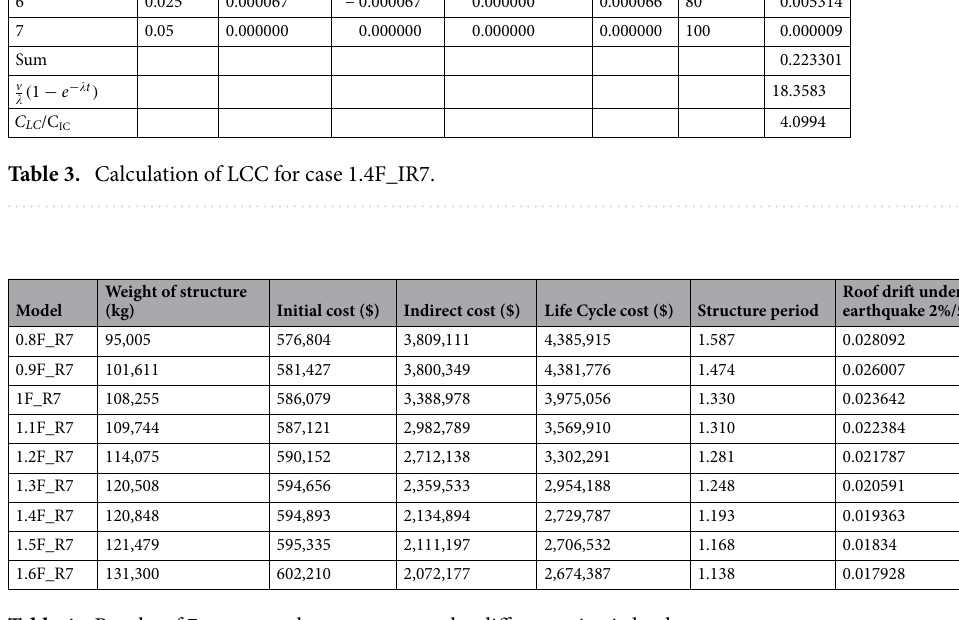
Table 4. Results of 7-story regular structures under different seismic loads.